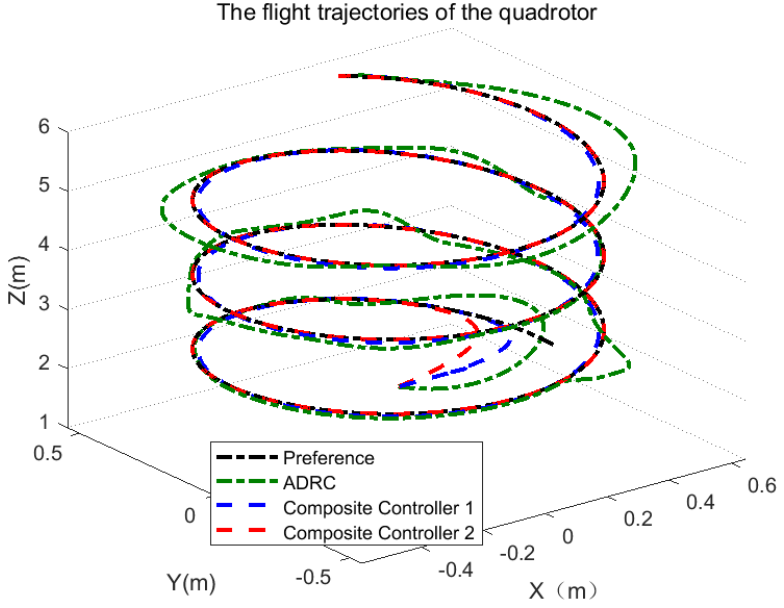
Figure 16. The flight trajectories of the QUAV under actuator time-varying fault and disturbance condition.